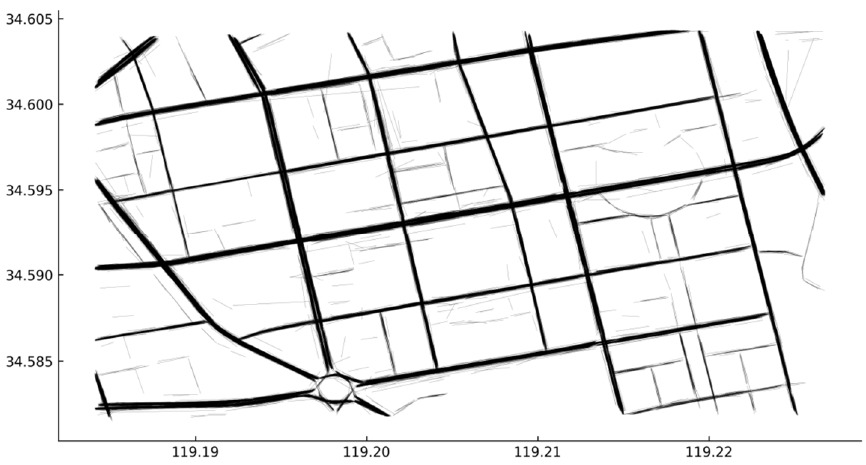
Figure 9. Extracted straight-line segments.